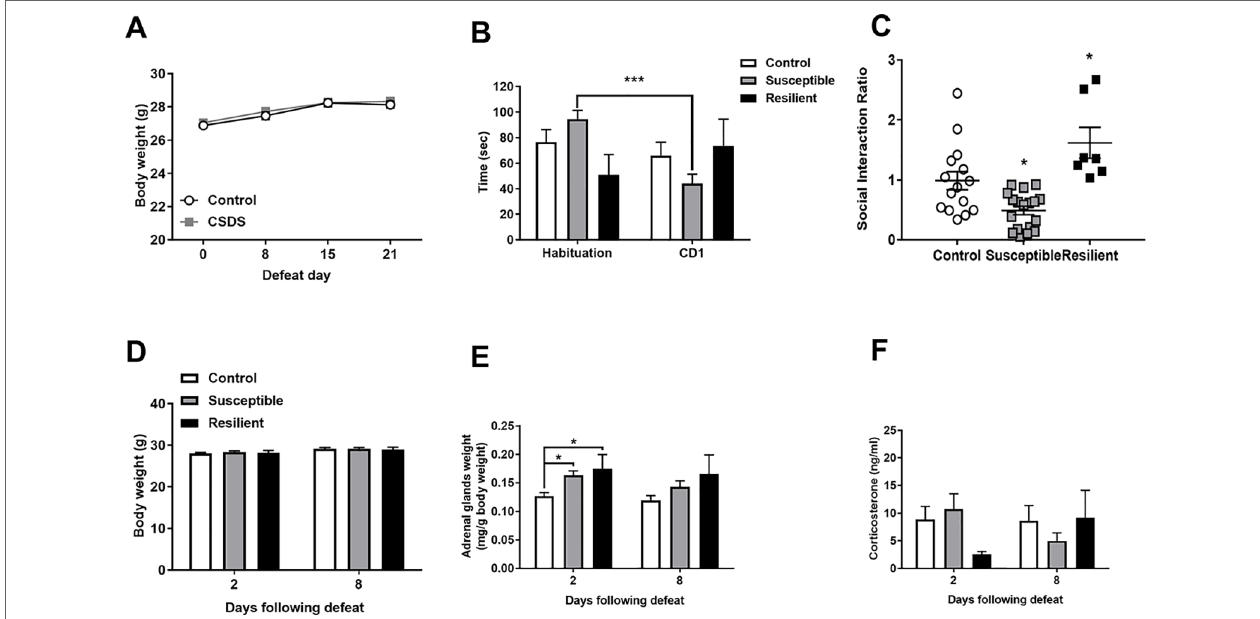
FIGURE 1 | Chronic social defeat stress (CSDS) induces social avoidance and adrenal hypertrophy without changes in basal corticosterone levels. Body weight throughout the stress procedure did not differ between groups (A) . Following CSDS, susceptible mice spent significantly less time investigating a novel CD1 mouse than an empty cage in the social interaction (SI) test (B) and significantly decreased the SI ratio in susceptible and increased SI ratio in resilient mice compared to controls (C) . CSDS did not alter body weight at 2 or 8 days following the final defeat (D) but induced an increase in adrenal weight in both susceptible and resilient mice at 2 days but not 8 days (E) with no changes in basal corticosterone (F) . *** p < 0.001, two-way repeated measures (RM) ANOVA with Sidak post hoc comparisons; * p < 0.05, susceptible and resilient groups compared to control, one-way ANOVA with Sidak post hoc